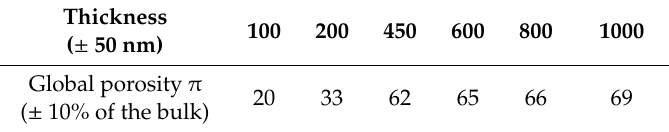
Table 1. Calculated global porosity as a function of the W film’s